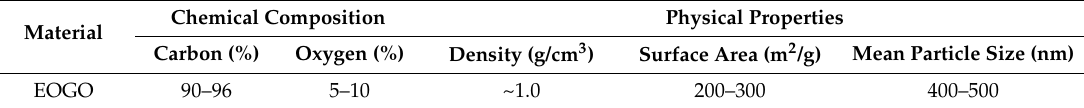
Table 2. The chemical composition and physical properties of edge-oxidized graphene oxide (EOGO)